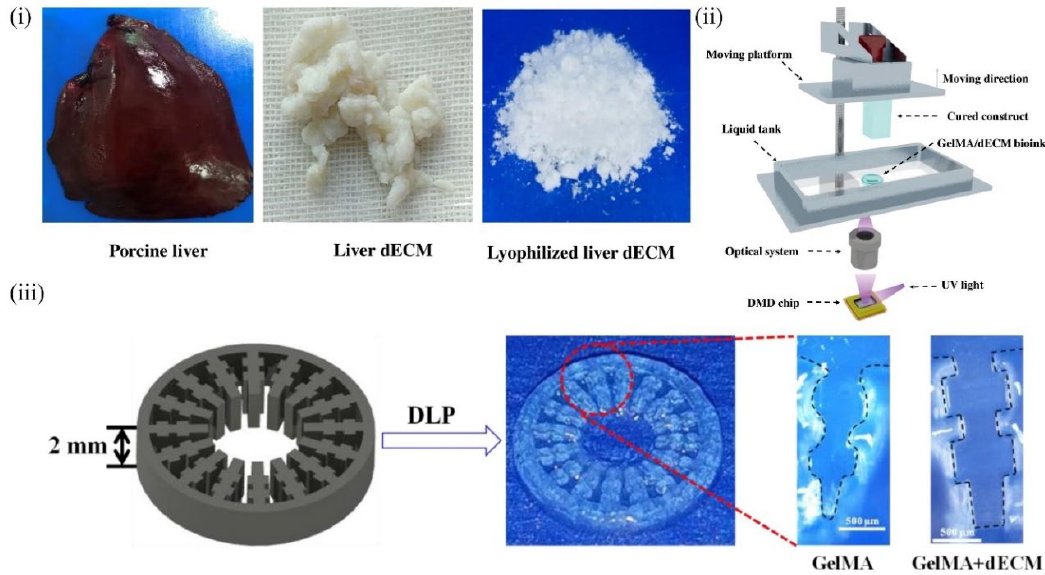
Figure 6. A typical example of liver-derived dECM bioink for 3D printing application: ( i ) digital image of fresh porcine liver/liver dECM/lyophilized liver dECM; ( ii ) schematic of DLP-based 3D printer; and ( iii ) designed liver microtissue model and DLP printing results [68].